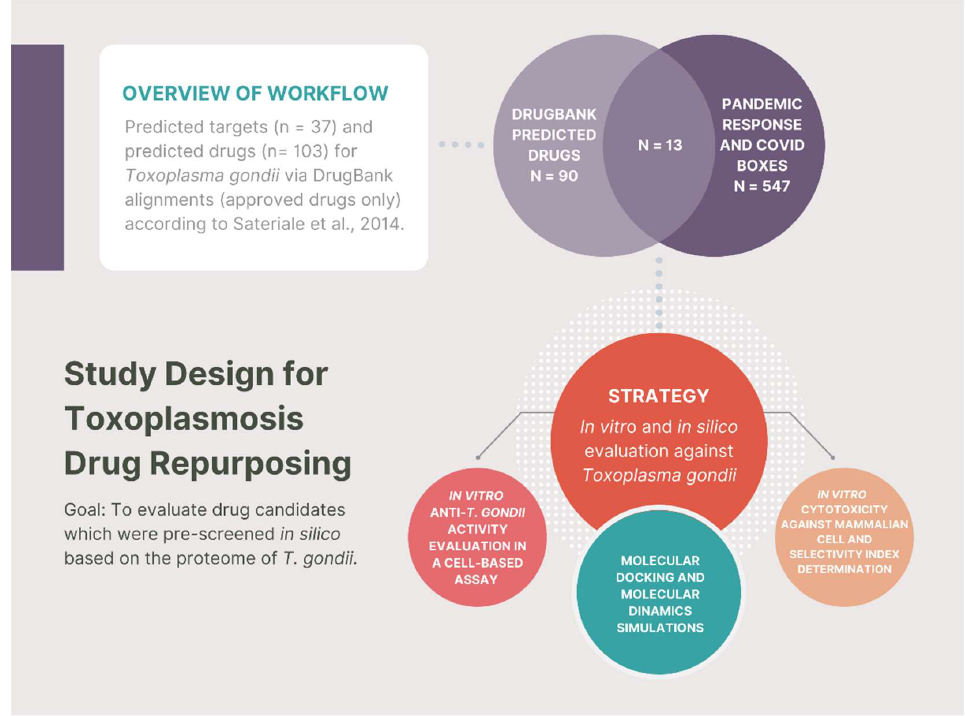
Figure 1. Study design and workflow. Following the publication of predicted drugs for T. gondii via DrugBank alignments by Sarteriale et al., (2014) [13], we selected 13 compounds from Pandemic Response and COVID Boxes to be in vitro evaluated against T. gondii and for Molecular Docking and Dinamics Simulations in the present work. Among the 13 selected compounds, three demonstrated in vitro anti- T. gondii activity in the nanomolar range (almitrine, bortezomib, and fludarabine), and ten compounds demonstrated anti- T. gondii activity in the micromolar range. We crossed the in silico screening results achieved by Sarteriale et al. 2014 [13] with the MMV libraries, aiming to build a small enriched compound collection for in vitro drug testing.